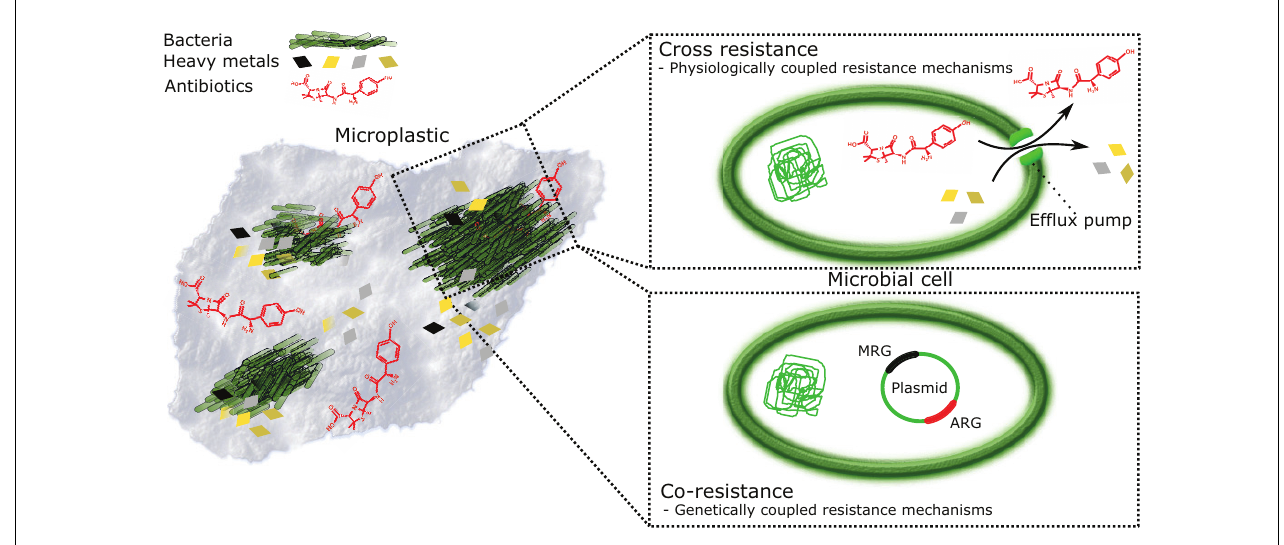
FIGURE 1 | Plastisphere is a potential hotspot for evolution of antimicrobial resistance (AMR). Persistence and surface characteristics of microplastics make it an excellent reservoir of microbes and pollutants, such as heavy metals (HMs) and antibiotics (ABs). Together they form miniature ecosystems, plastispheres, where AMR is promoted by (i) cross-resistance where resistance mechanisms to HMs and ABs are physiologically coupled, for example, efflux pumps (Baker-Austin et al., 2006; Seiler and Berendonk, 2012); and (ii) co-resistance where antibiotic resistance genes (ARGs) and metal resistance genes (MRGs) are present on the same mobile genetic element and thus genetically coupled, whereby selection for metal resistance in, for example, animal gut, and anthropogenically contaminated soils and water bodies lead to automatic selection of ARGs (Baker-Austin et al., 2006; Seiler and Berendonk, 2012; Li et al.,